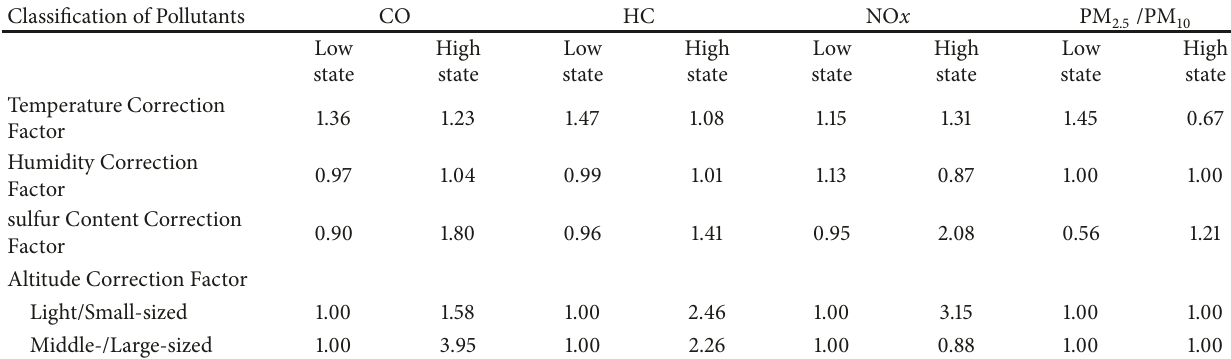
Table 3: Gasoline vehicle environmental parameter correction factor.